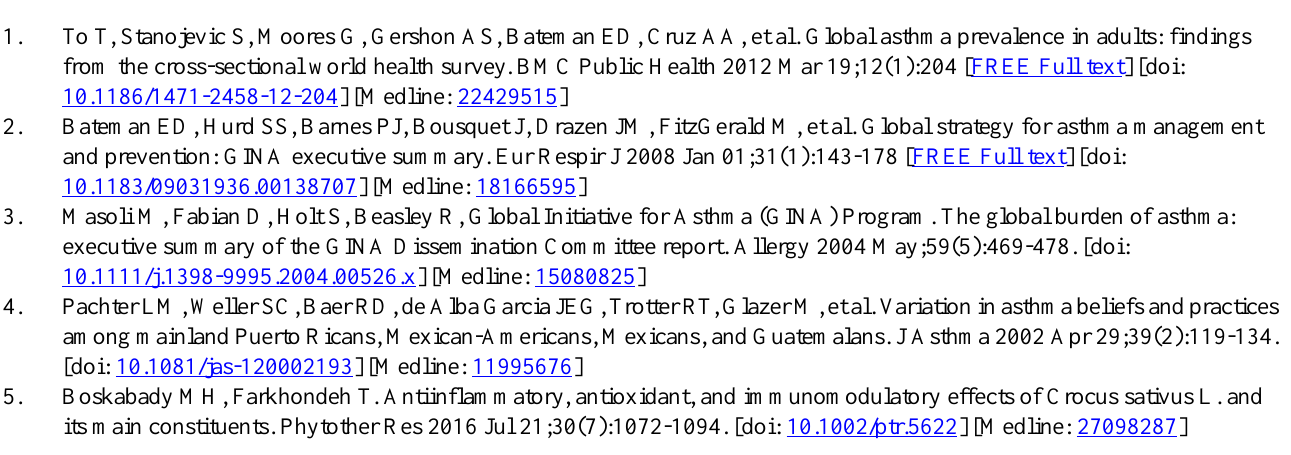
algorithm–modified neural network on additional groups of patients with allergic asthma or other types of asthma. In